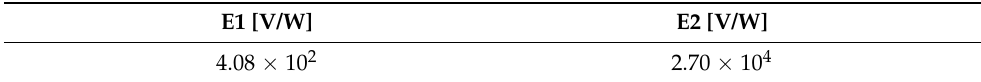
Table 4. Proposed Thermopiles Measured Responsivity.